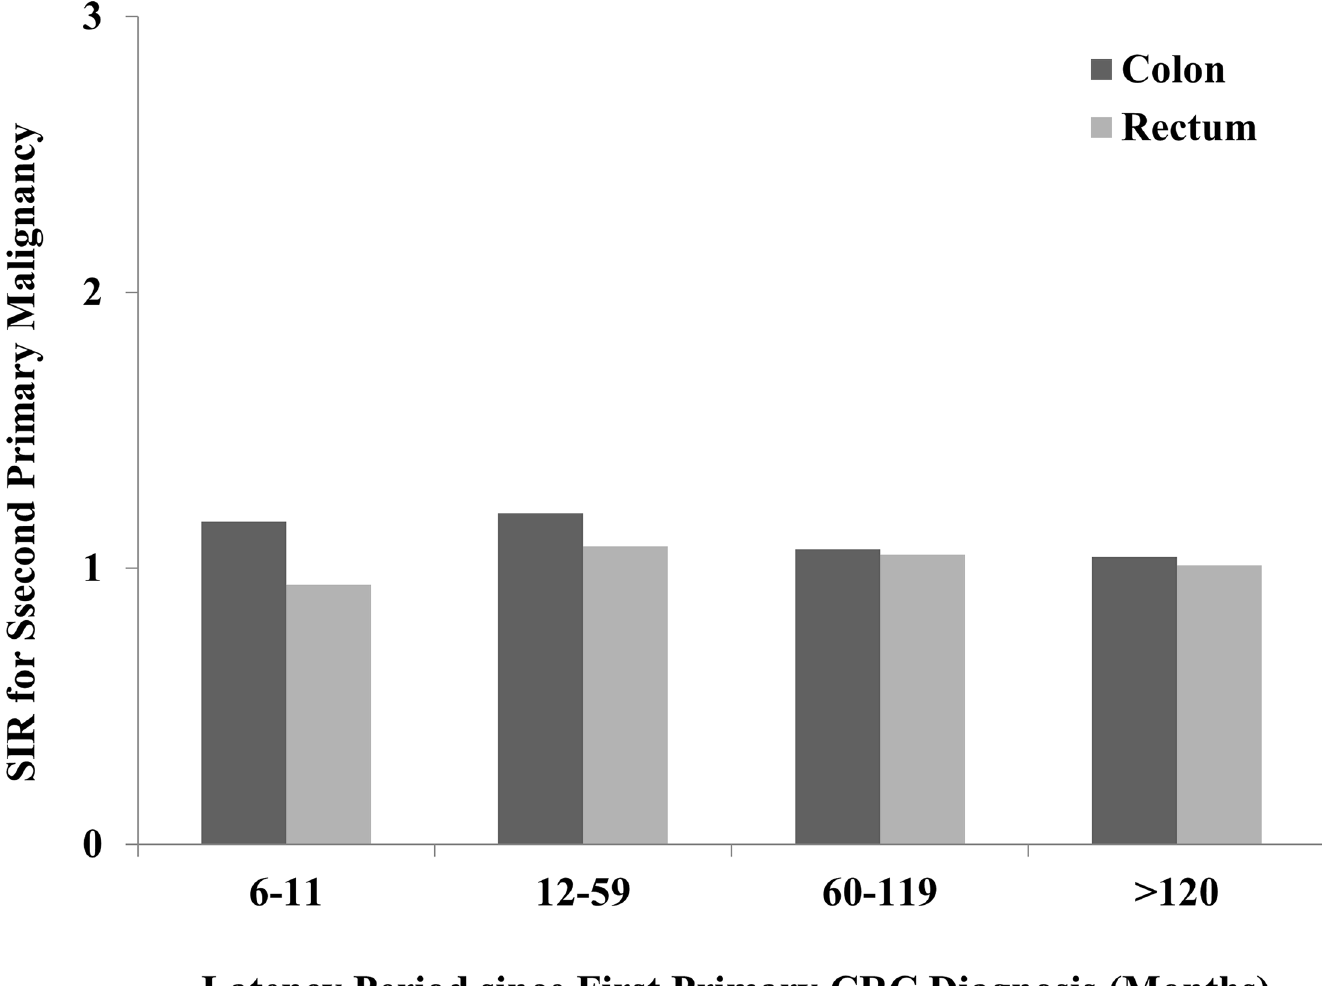
Fig 6. SIRs of SPMs in colon and rectal cancer patients by